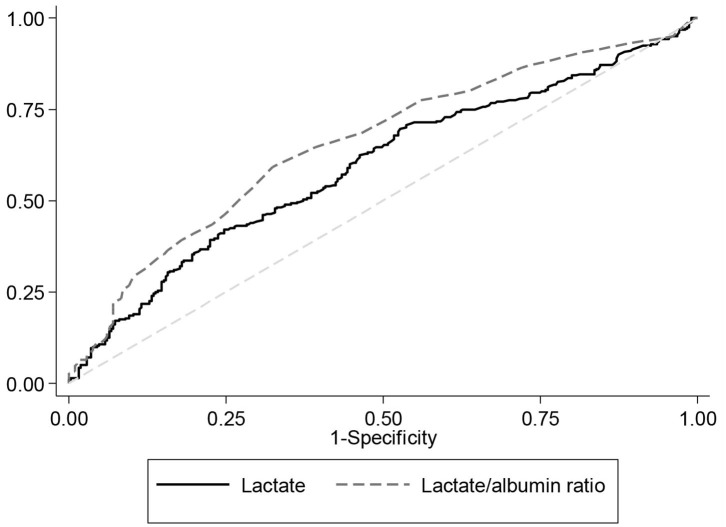
Receiver operating characteristic curves for in-hospital mortality among patients in septic shock. The area under the receive operating curve (AUC) for in-hospital mortality among patients with septic shock. The AUC for lactate is 0.59 (95% CI 0.55–0.64) and that for the lactate/albumin ratio is 0.66 (95% CI 0.61–0.70, p < 0.001).